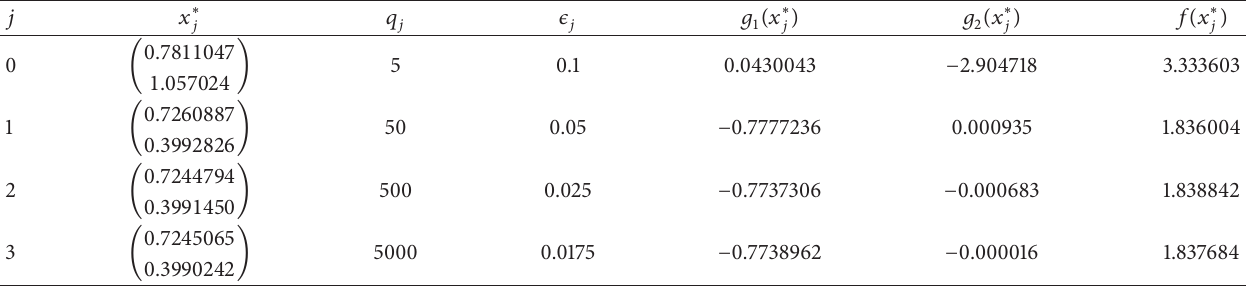
Table 1: Numerical results for Example 1 by Algorithm